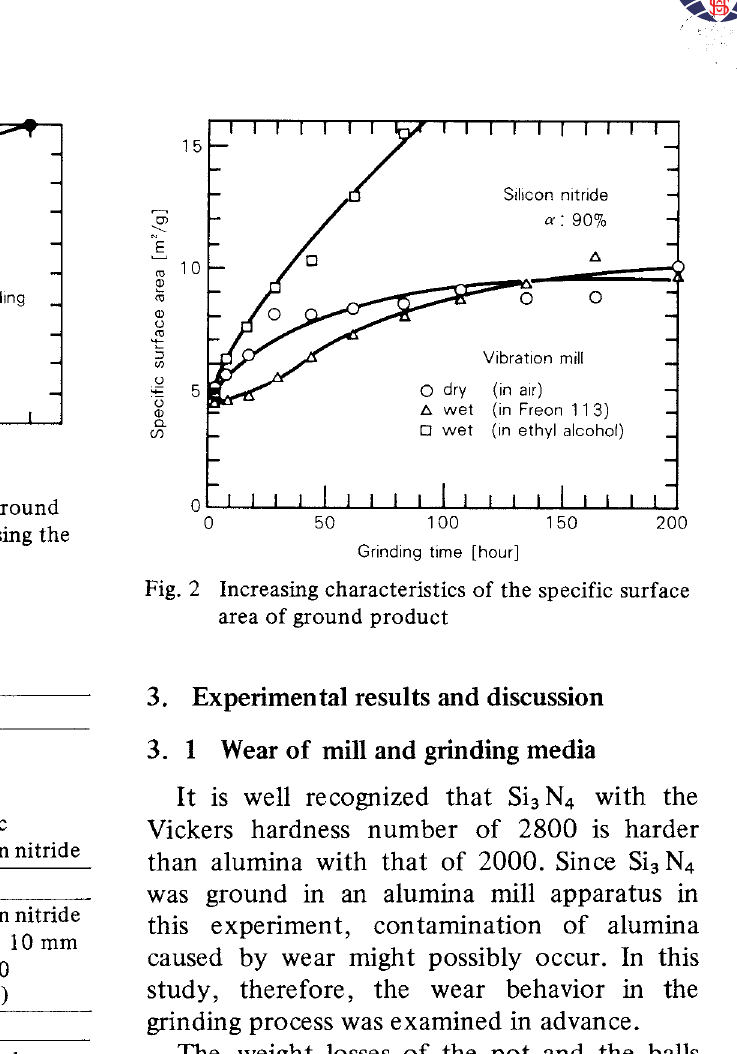
Fig. 2 Increasing characteristics of the specific surface area of ground